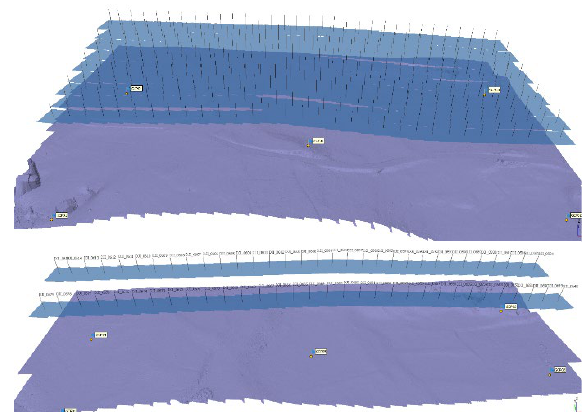
Figure 1. Top: view of the BWH_1 LN_8 configuration (nine strips, 80% side-lap) with 5 GCP; bottom: view of the BWH_3 LN_6 configuration (two strips, 60% side-lap) with 5 GCP Combining the images of the four different photogrammetric blocks, the six configurations illustrated in the previous sections are obtained. Next, the six image blocks are oriented in Agisoft Metashape (Agisoft, 2021) v. 1.7.1 and the tie-points extracted Table 2 – Three different rectangular block shapes considered, along with their corresponding image points are exported. In this made from 9 strips to 3 strips with 80% side-lap (and the way, in the simulations, the actual distribution of tie points can respective 60% side-lap) mimic the real-world image block. All 36 combinations of configurations (6), overlaps (2 combinations - removing one The number of cross strips remains unchanged for all different every two strips to obtain the 60% side-lap blocks) and width-to- width-to-height ratios, while their lengths are cut accordingly. height ratios (3 combinations - removing the first half of 2/3 of Combining configurations (6 different blocks) with overlap the original image block) have been